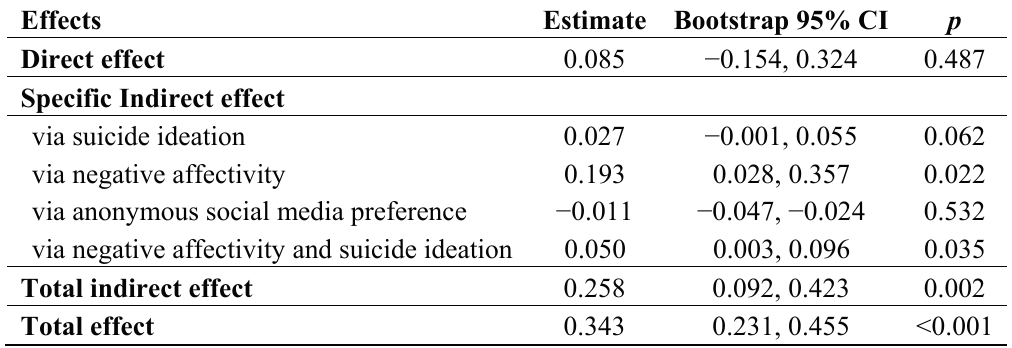
Table 5. Total, direct, and indirect effects from vulnerable personality to Weibo suicide communication of Model